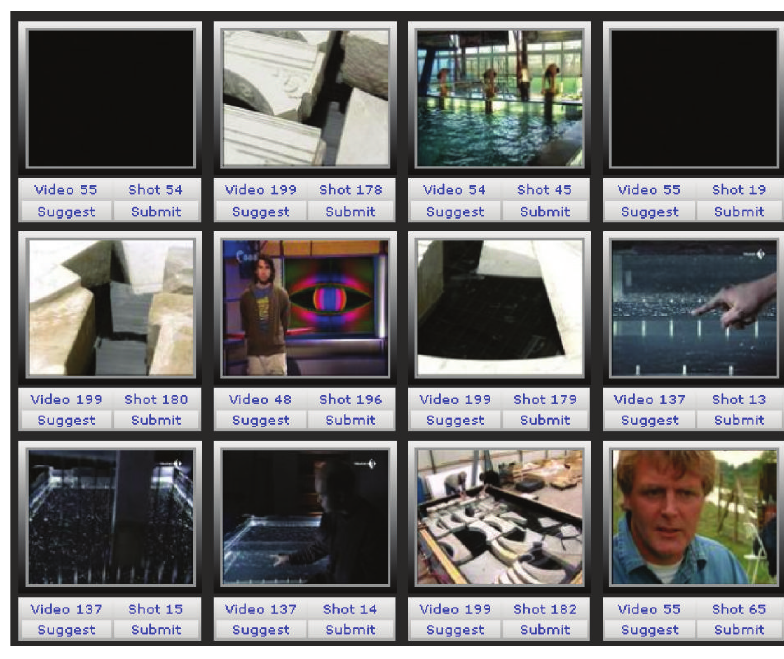
Figure 9: The user submits a textual query with the keyword “water” searching in the ASR transcripts.